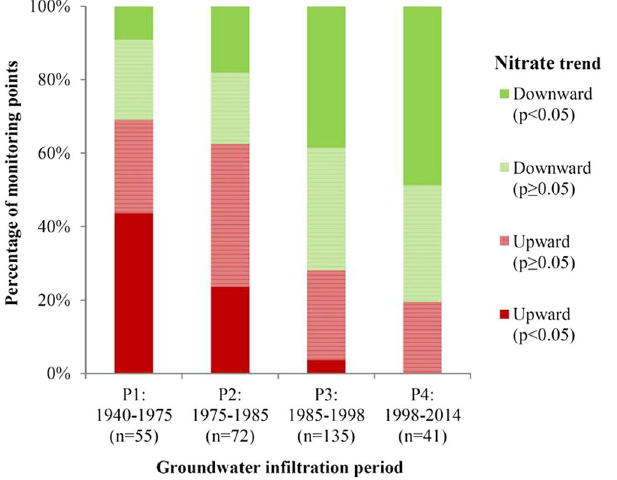
Figure 2. Development in nitrate trends in oxic groundwater based on linear regression of nitrate time series in 250 individual monitoring wells. Trends are divided into four groups according to direction of the trend (slope of the regression line) and four groundwater infiltration periods (P1 – P4). Both significant (p < 0.05) and non- significant (p ≥ 0.5) trends are shown. The numbers of monitoring wells in each period are shown (n).